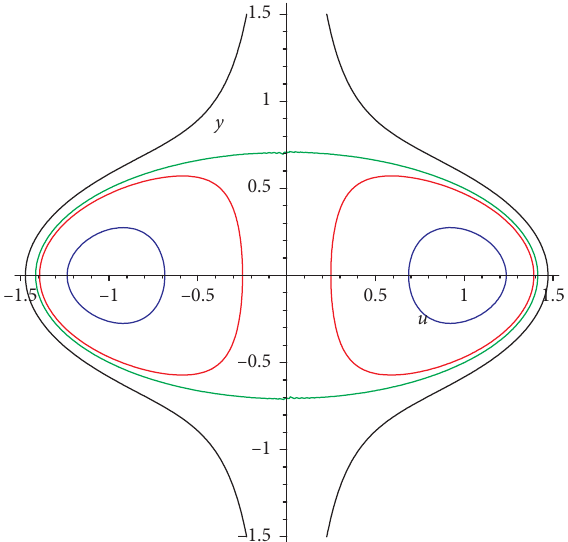
Figure 6: The phase portrait of system (2) for c � − 1 , g < 0.